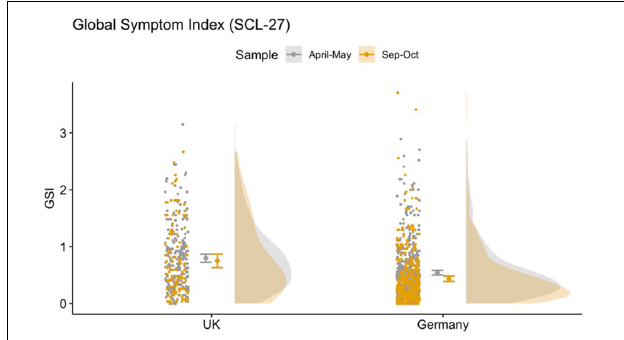
FIGURE 1 | Raincloud plot for GSI across country and timepoint, showing data distribution (the “cloud”), jittered raw data (the “rain”), mean and standard